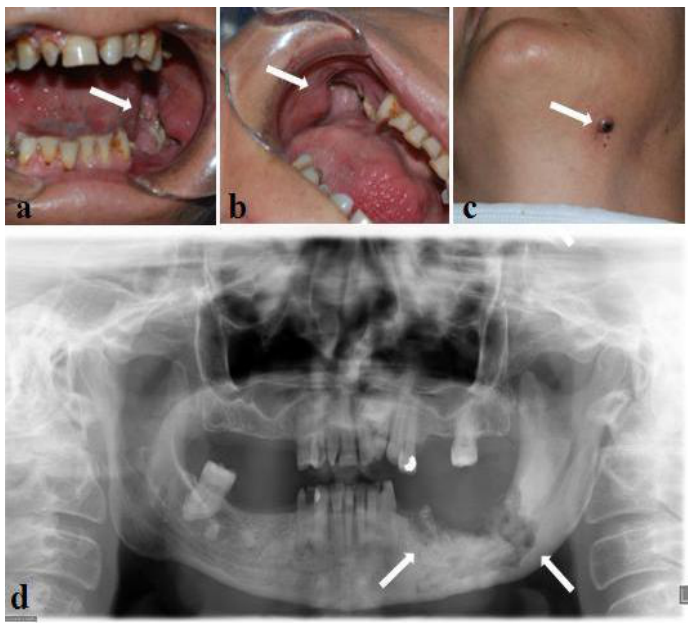
Figure 2. Clinical photographs and radiographic image from Case Report 2 (a,b) Intraoral examination of the patient with metastatic breast cancer who used pamidronate and zoledronic acid for at least four years revealed an extensive area of osteonecrosis; (c) The left mandible had a large area of osteonecrosis that became secondarily infected, leading to the formation of an extraoral fistula; (d) Panoramic radiograph of patient showing a body defect with ill-defined margins and multiple irregular radiopacities interspersed within the lesion, indicating multiple sequestra posterior to the mandibular left premolar-molar